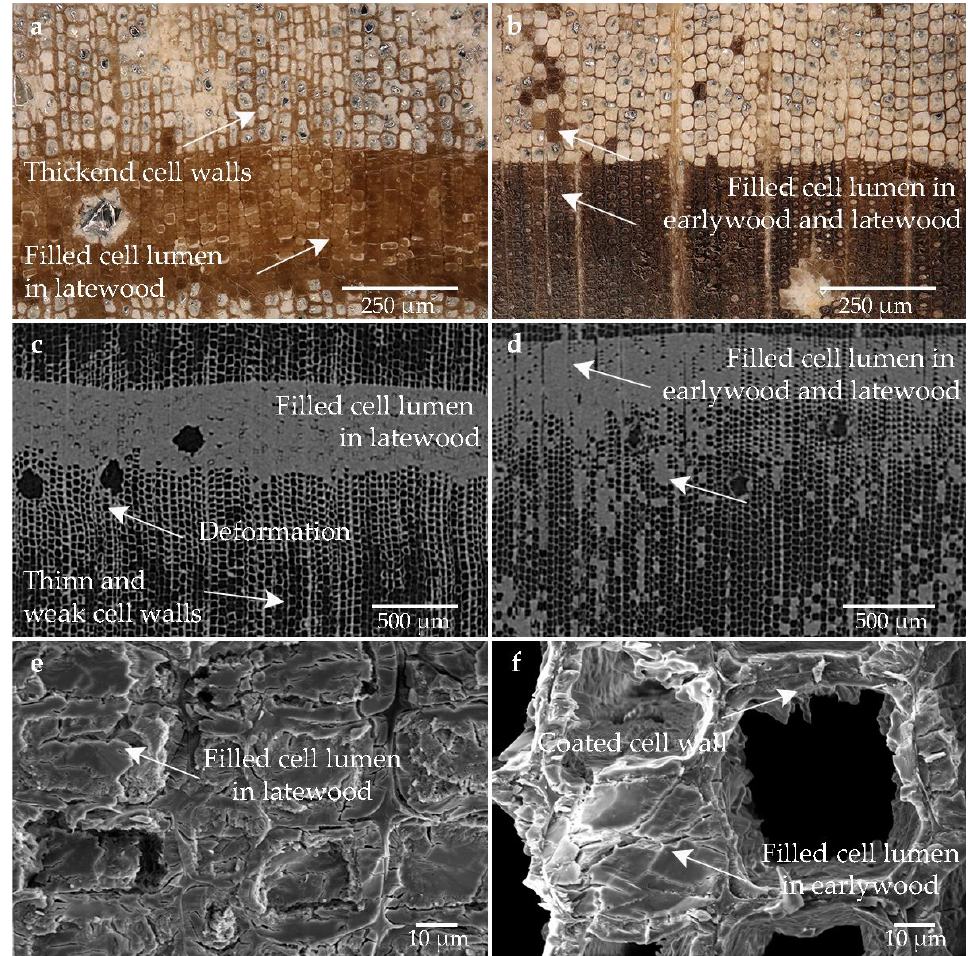
Figure 5. Microscopic wood structure of sample conserved with lactitol/trehalose (Pi1-LaTr) ( a ) RLM image from the heavily degraded area; ( b ) RLM image from the low degraded area; ( c ) CT image of the cross section of the heavily degraded sample; ( d ) CT image of the cross section of the low degraded sample; ( e ) SEM image of the latewood tracheids; ( f ) SEM image of the earlywood tracheids in the heavily degraded area.